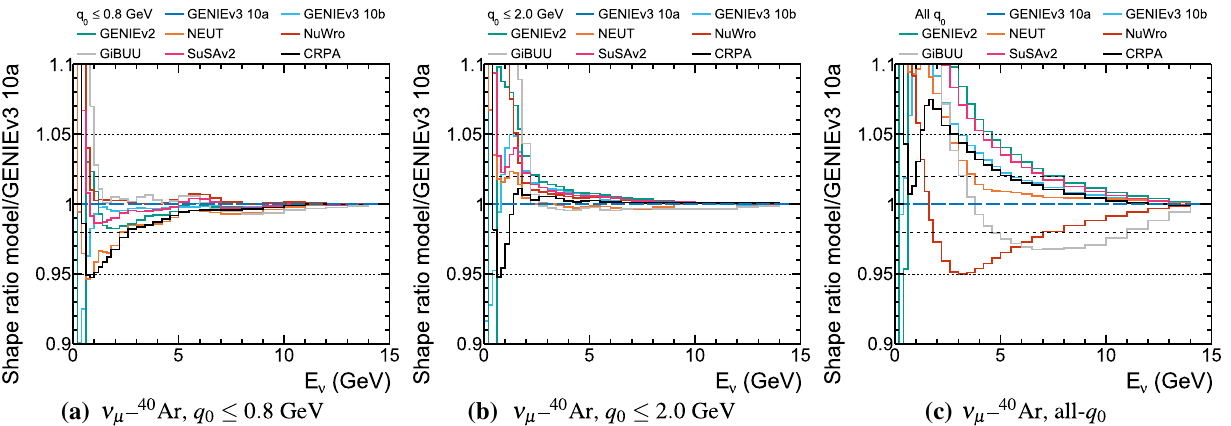
Fig. 5 Comparison of the shape-only ratios of the charged-current ν μ – 40 Ar cross section with q 0 ≤ 0.8, 2.0 GeV and all- q 0 as a function of E true ν , with respect to the GENIEv3 10a prediction. Horizontal long (short) dashed lines have been added at ± 2% ( ± 5%), to guide the eye in assessing the scale of the